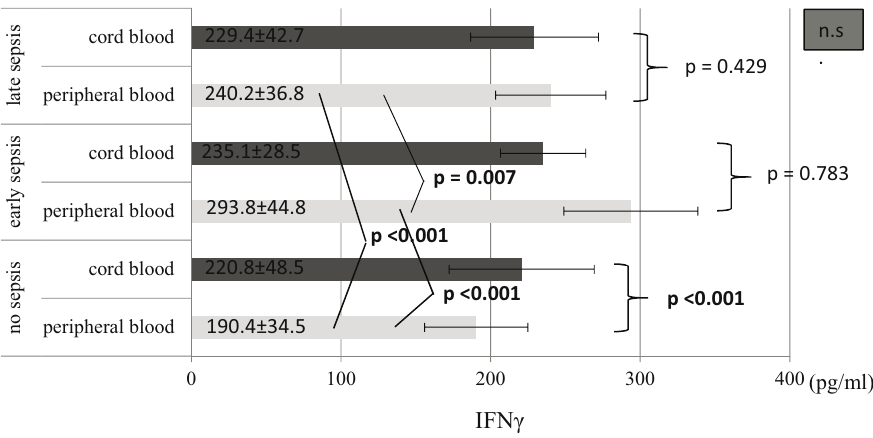
Figure 1: IFN - γ ( pg/mL ) levels in the cord blood and peripheral blood among sepsis subgroups and control group. The plasma levels of IFN - γ was evaluated as described in Material and methods section. Data were expressed as mean ± SD. Abbreviations: no sepsis – participants without sepsis development; early sepsis – participants who developed sepsis in fi rst 72 h of life; late sepsis – participants who developed sepsis after 72 h of life; n.s. – non - signi fi cance.